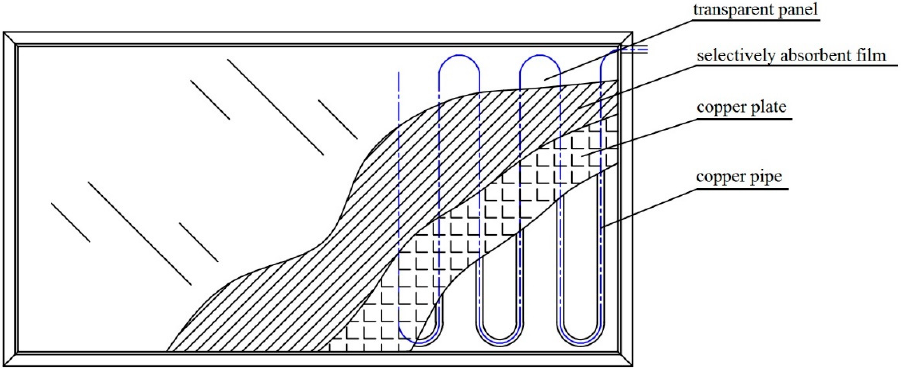
Figure 3. Structure of the solar collector.